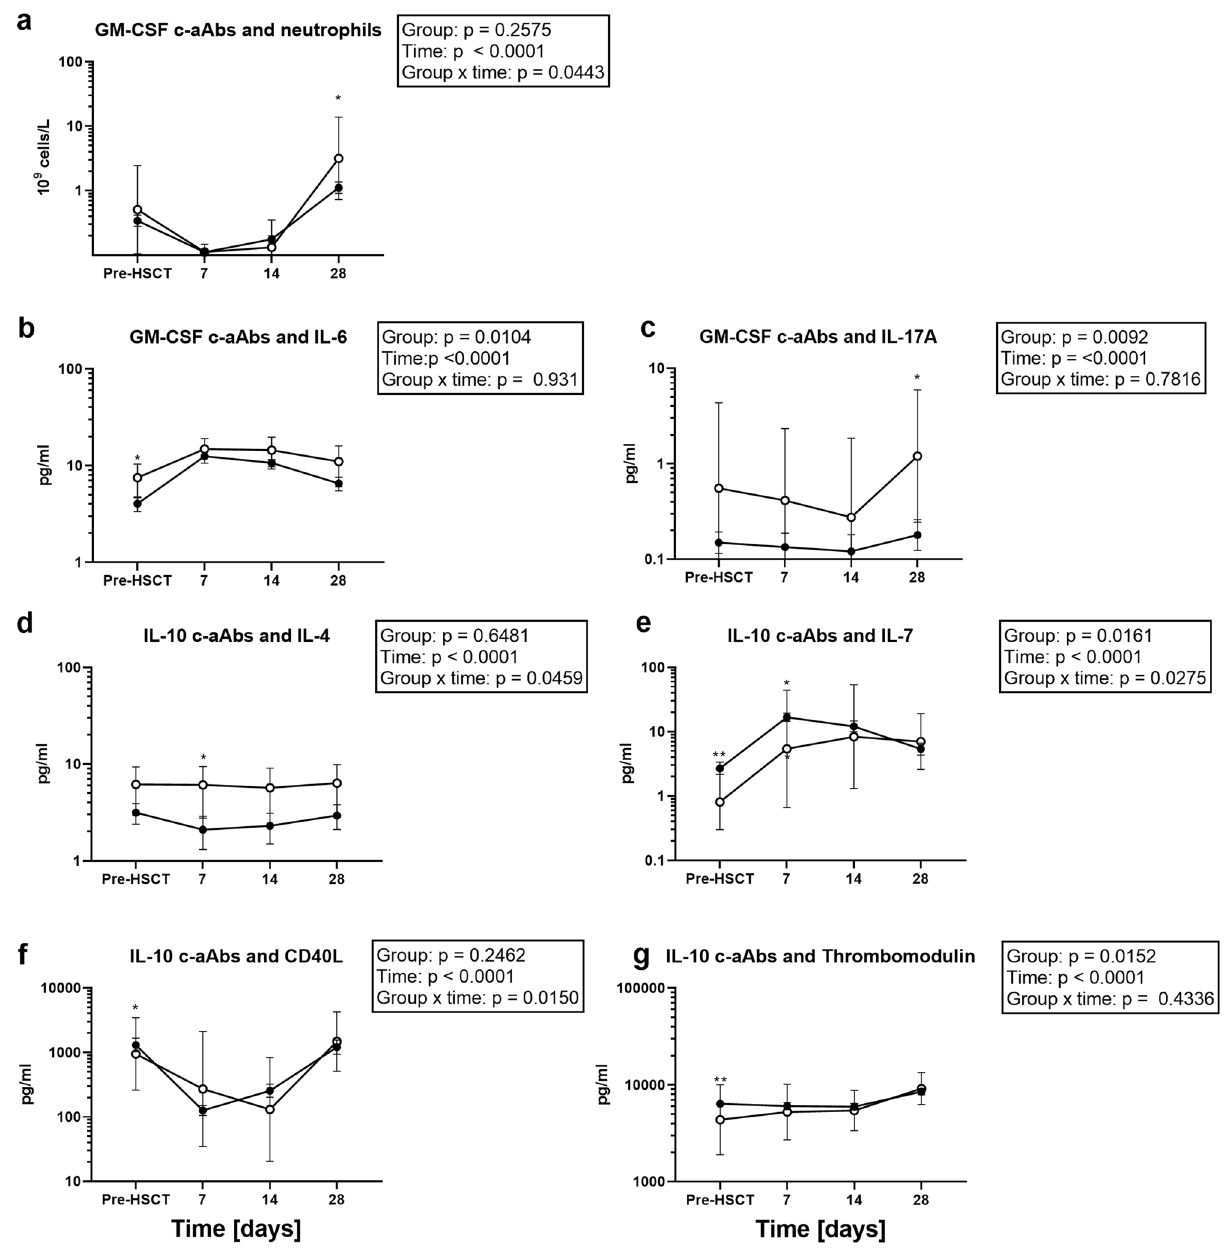
Figure 2. GM-CSF and IL-10 c-aAbs as predictors for cell and biomarker trajectories pre- and post-HSCT. Results from linear repeated mixed measures models of all patients (n = 131) with biomarker concentrations and cell counts as dependent variables and time and high-titre c-aAbs as independent variables. Analyses performed in Stata (StataCorp. 2019. Stata Statistical Software: Release 16 . College Station, TX: StataCorp LLC). Filled circles represent individuals with nonhigh titres of c-aAb, and clear circles represent individuals with high titres of c-aAb. Data in ( a , c ), and ( e – g ) are geometric means with 95% confidence intervals in the case of log-transformed variables. Data in ( b ) and ( d ) are estimated mixed model regression coefficients with 95% confidence intervals in the case of untransformed variables. P -values are displayed for group (c-aAb high-titre or not), time and group × time effects as assessed by likelihood ratio post hoc tests. The effect of high c-aAb levels on biomarker levels compared to nonhigh c-aAb levels on a date-by-date basis was assessed by testing for a time/ c-aAb interaction term as an outcome predictor; here * denotes P -value < 0.05 and ** denotes P -value < 0.01. Only results for cells or biomarkers with a significant group or group × time effect and with normally distributed residuals are shown. The results with a significant group × time effect with oscillating signals at the day 7 and 14 time points were excluded as biologically